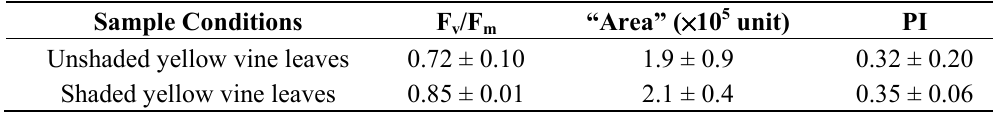
Table 2. Photosynthetic parameters of the shaded and unshaded cranberry leaves determined by chlorophyll fluorescence kinetics [34].